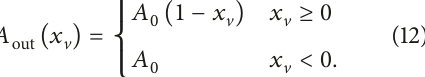
Figure 7. The movement of the ball valve allows flow from the outlet to be controlled under a pressure difference. If the ball valve is moved away from the outlet, the outlet area will become the same as the inlet area, which is kept constant.